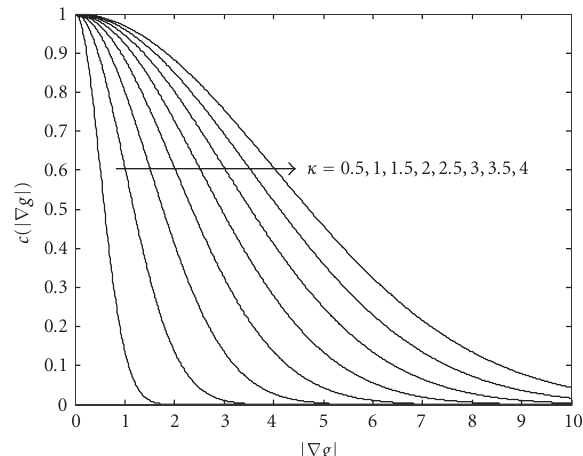
Figure 2: The function shape that a ff ects the behavior of anistropic di ff usion in